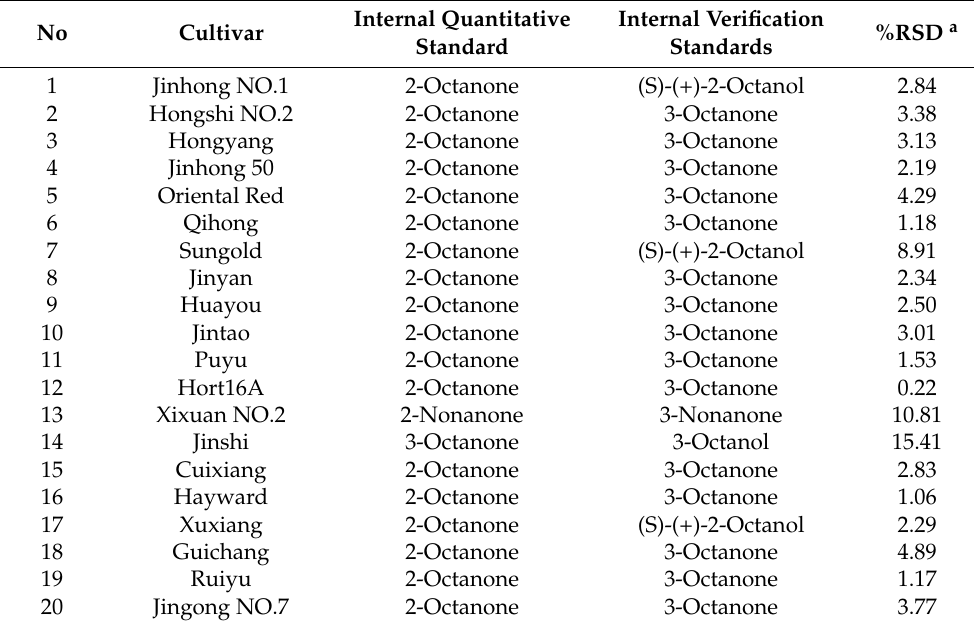
Table 1. The selection of internal